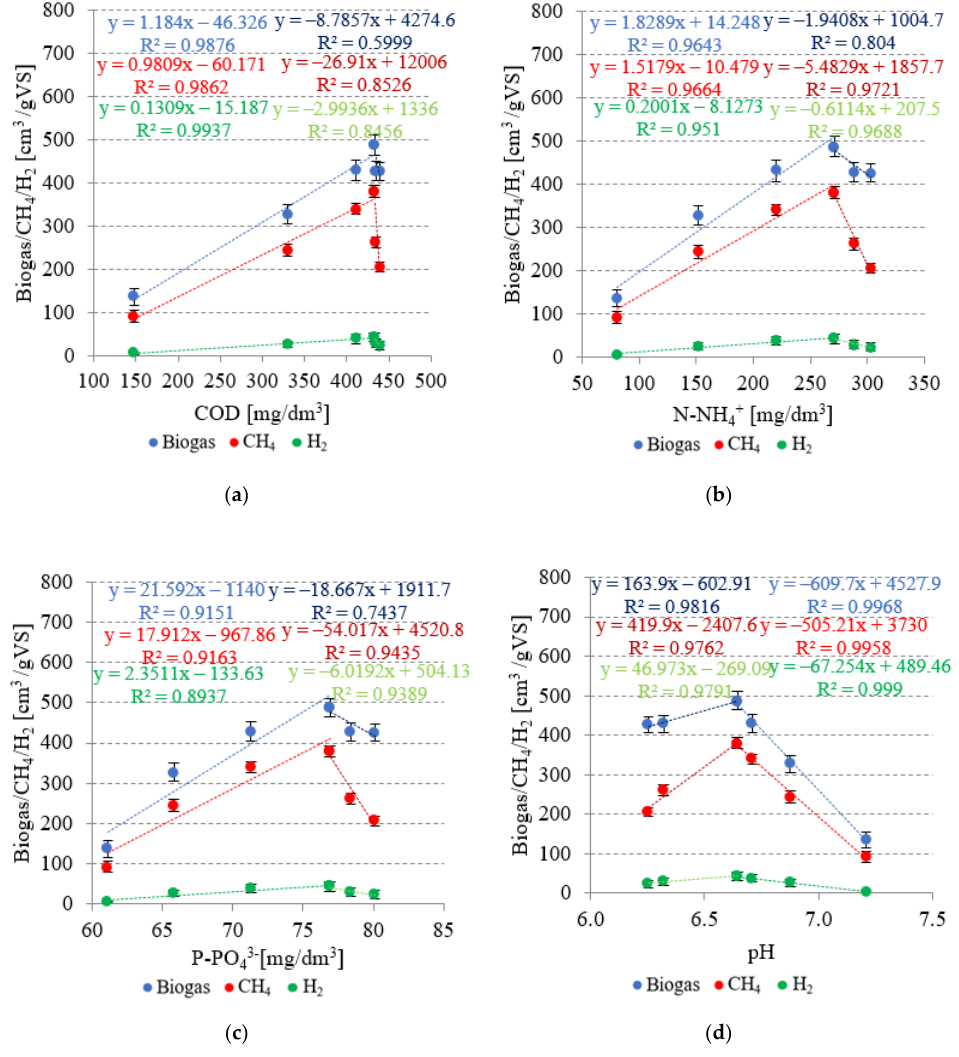
Figure 9. Correlations between: ( a ) COD, ( b ) N-NH 4+ , and ( c ) P-PO 43− concentrations in the dissolved phase, ( d ) pH, and the yields of biogas, CH 4 , and H 2 .